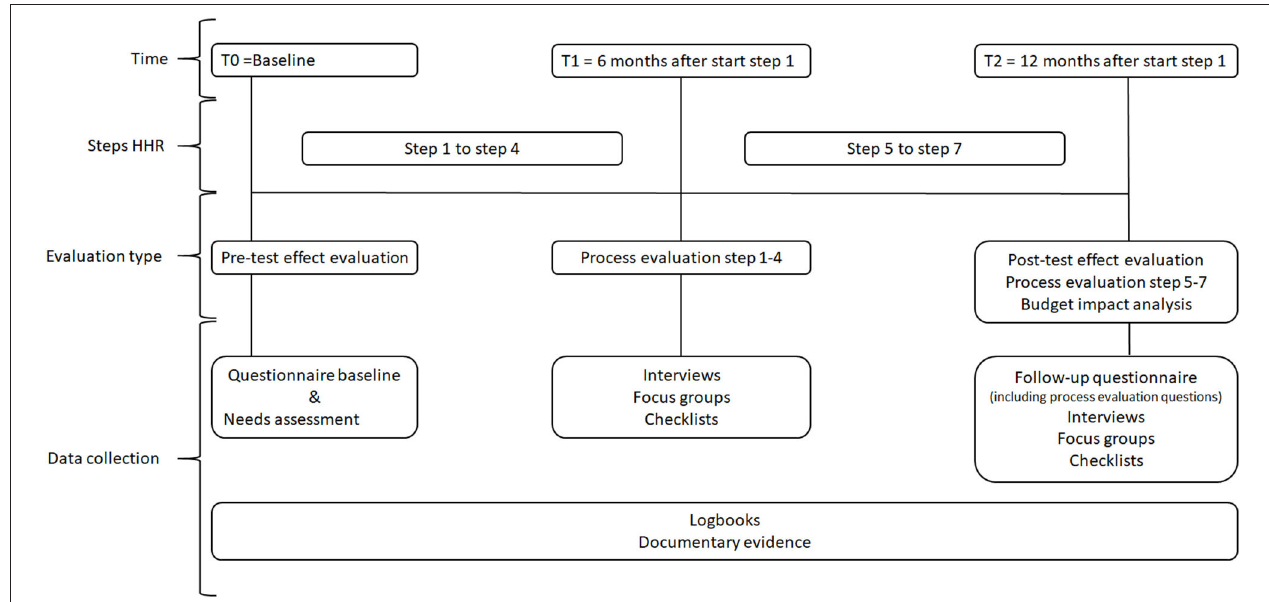
FIGURE 2 | Overview evaluation moments and data